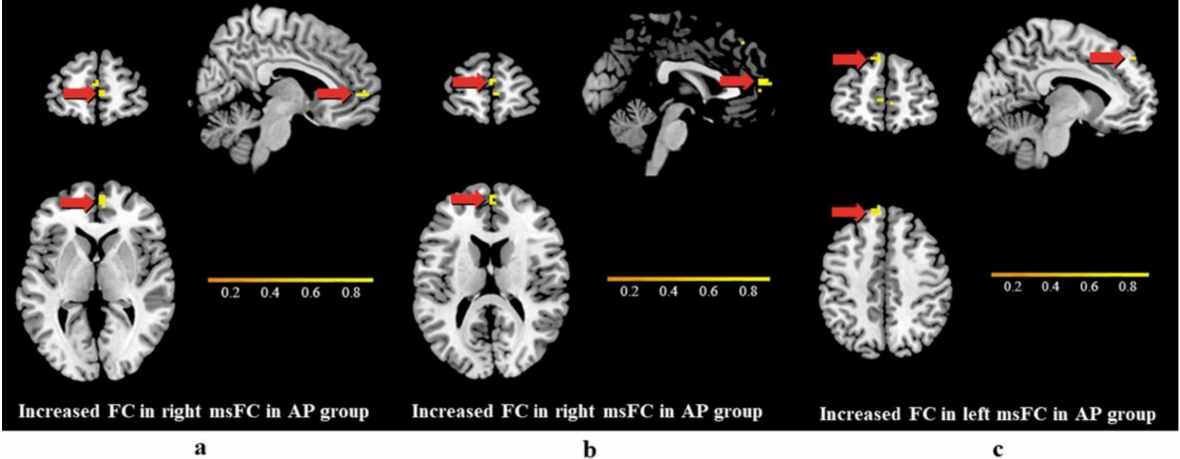
Figure 3. The images show increased FC from the right SPL (ROI 1) to the bilateral medial superior frontal cortex (smFC) in the AP group compared with the OP group at rest. In the DMN, voxel-wised FC between the right SPL and the right smFC were significantly different between the AP group and the OP group ( a ). In the DMN, voxel-wised FC between the right SPL and the right smFC increased in the AP group ( b ). In the DMN, voxel-wised FC between the right SPL and the left smFC also increased in the AP group ( c ). The red arrow shows the corresponding brain region. The right SPL was set as the seed because the GMV of this region was increased in the AP group (see Figure